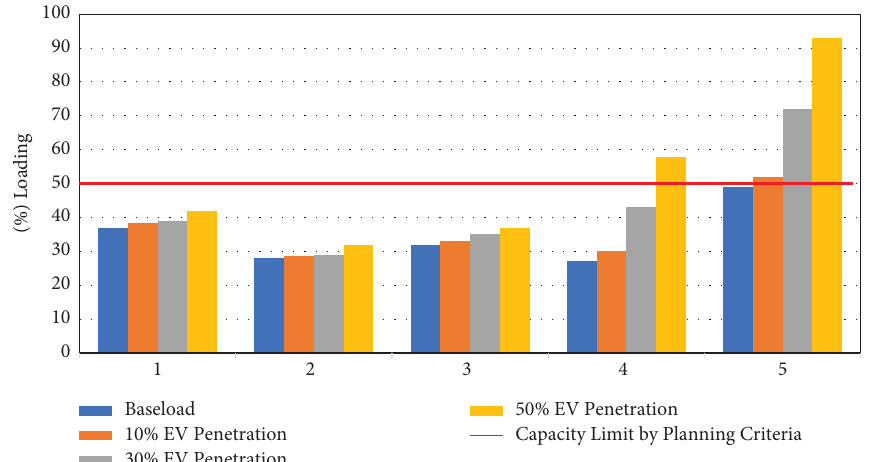
Figure 16: Percent loading of primary feeders under the three scenarios of EV penetration for uncoordinated charging.